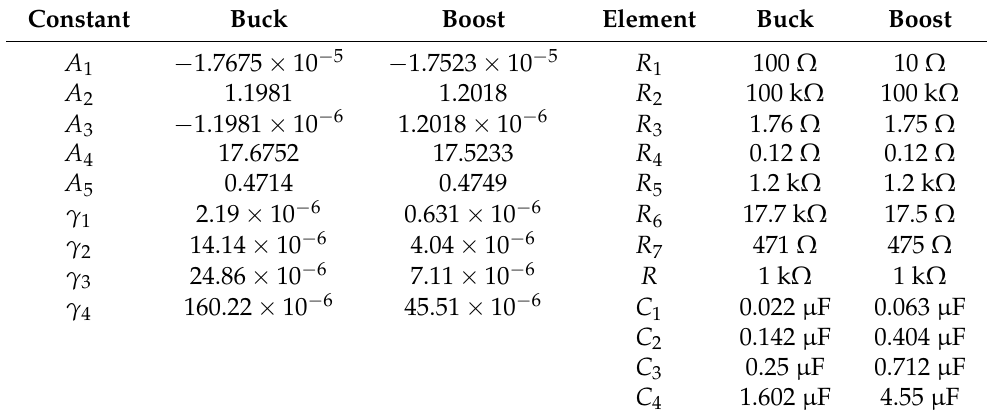
Figure 9. ( a ) Electrical representation of partial fraction expansion of controller (18). ( b ) Electrical representation of controller (18) for parameter values of Table 5. Table 5. Constants A ’s and γ ’s of controller (18) and parameter values for electrical arrangement of Figure 9b for buck and boost conversion